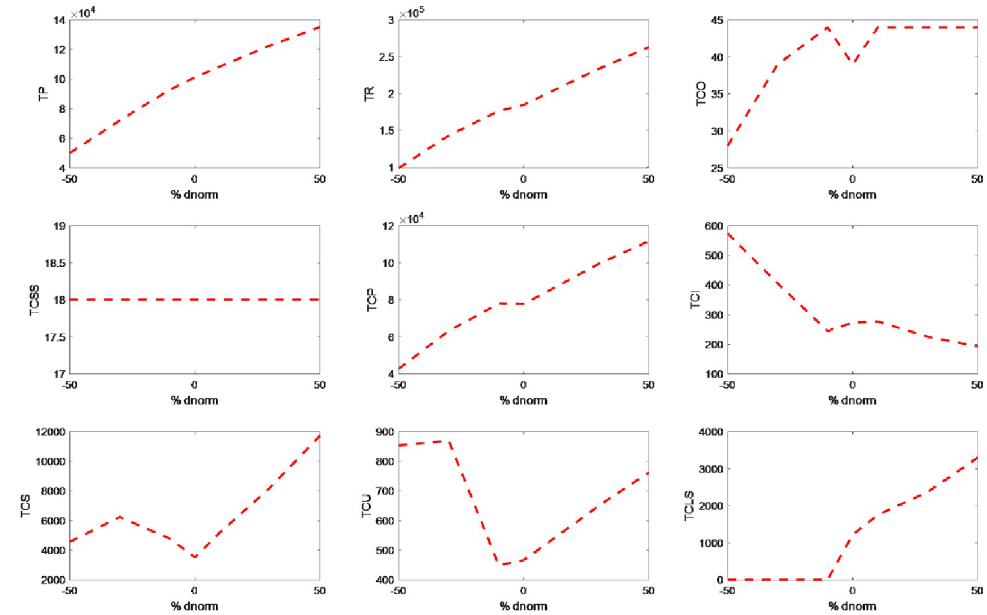
Fig 5. The costs and sales profits behavior for the changes in the demand parameter.